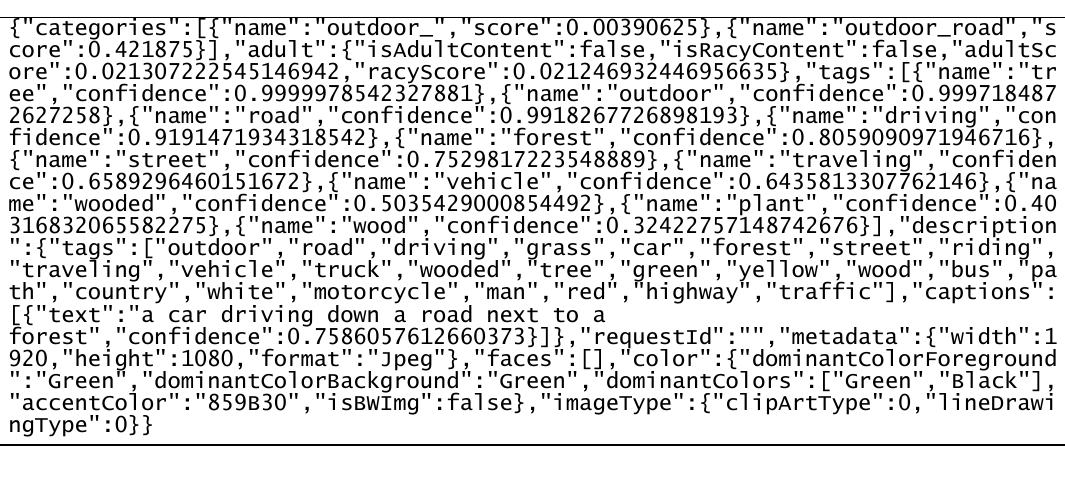
Figure 2. Sample image 2 and related API output.